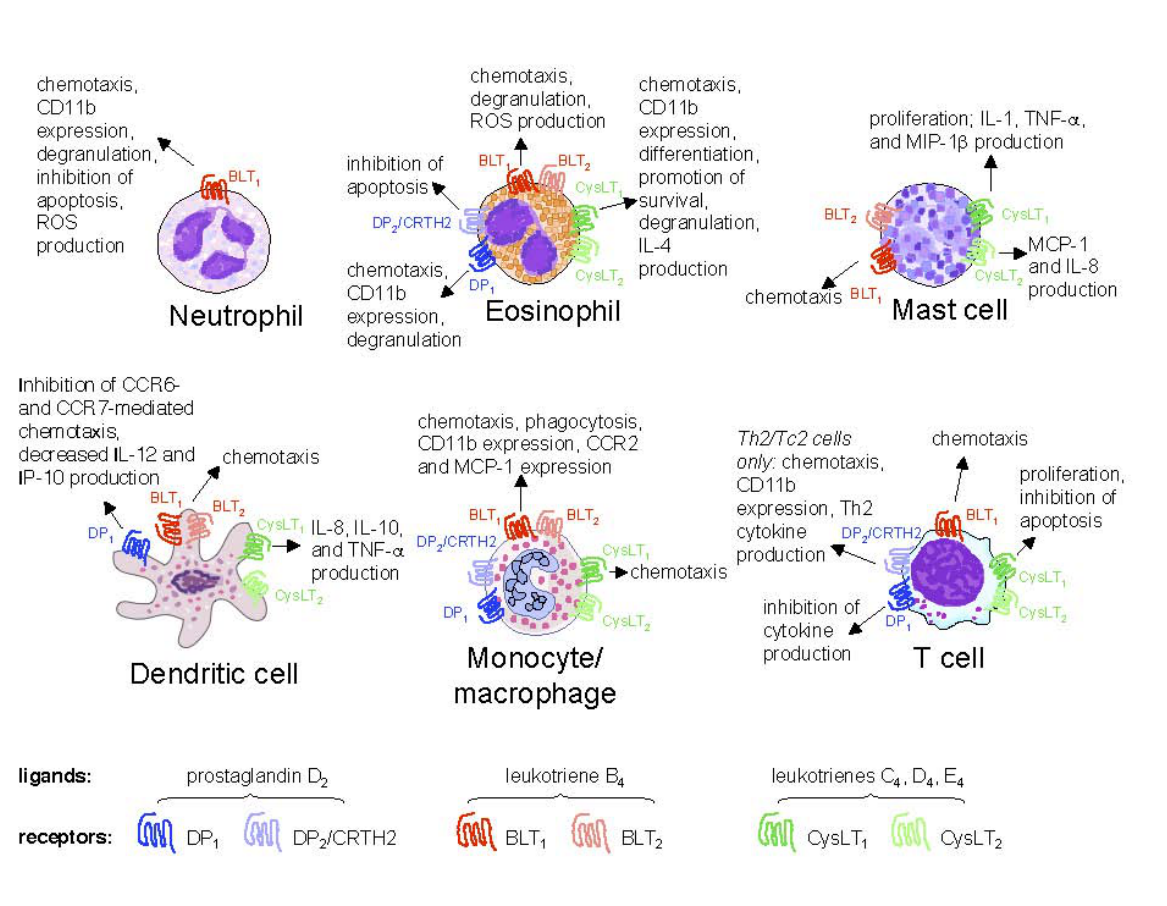
FIGURE 1. Distribution and functions of PGD 2 , LTB 4 , and CysLT receptors on human leukocyte populations. Leukocyte expression and known functions of DP 1 , DP 2 /CRTH2, BLT 1 , BLT 2 , CysLT 1 , and CysLT 2 receptors after activation with their respective ligands are depicted. This diagram represents human leukocytes; while mouse and other species have similar distribution and functions, significant differences exist, as described in this review. ROS, reactive oxygen